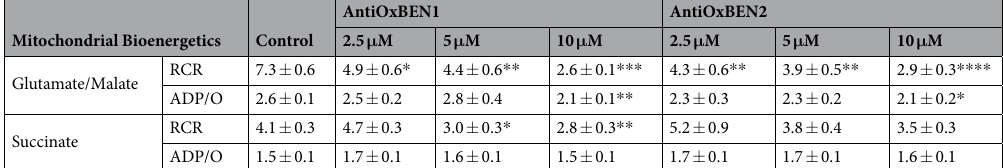
Table 2. Effect of AntiOxBENs on mitochondrial bioenergetics: mitochondrial respiratory control ratio (RCR) and efficiency of the phosphorylative system (ADP/O). Effect of AntiOxBENs on RCR and ADP/O values